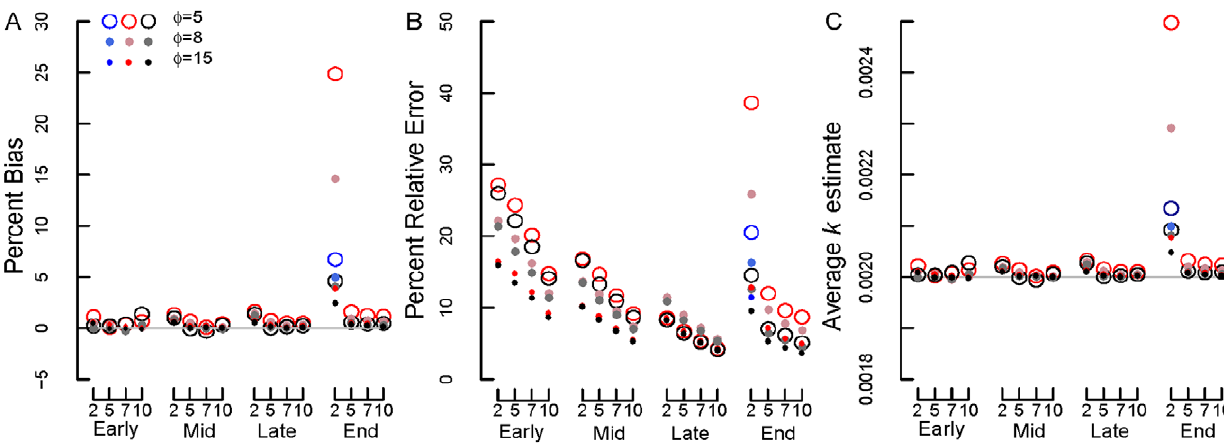
Figure 3. Simulation results for beta-distributed errors (option 2), k =0.002. (A) Percent bias, (B) percent relative error, and (C) average k estimate. Early, mid, late and end are early, mid, late and end stage decomposition simulations. The numbers 2, 5, 7 and 10 are the numbers of measurements used in each simulation. Blue circles=NLS, Red circles=Normal ML, gray/black circles=Beta ML. In most cases, nls=Normal ML so that the red circles cover the blue circles. In panel (A), the gray line shows 0% bias. In panel (C), the gray line shows the true k value, 0.002 d 2 1 .